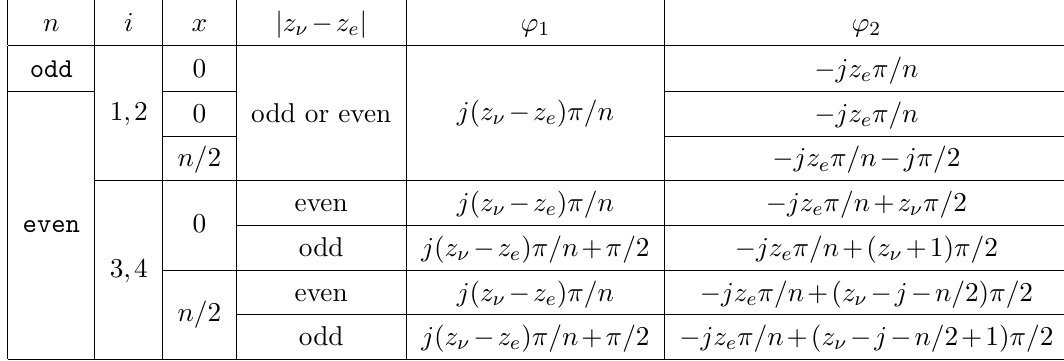
Table 5 . The values of the parameters ’ 1 and ’ 2 for the residual symmetry Z g e Z g (cid:23) = Z SR z(cid:23) 2